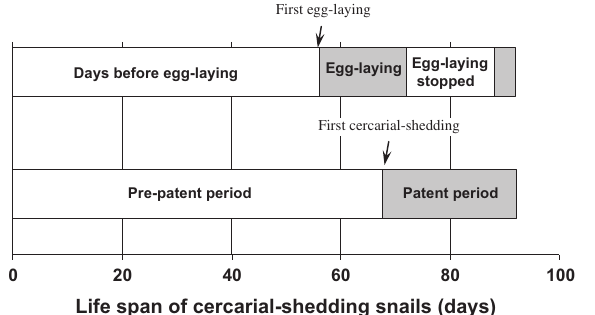
Figure 3. Mean durations of the egg-laying and patent periods for cercarial-shedding (CS) snails, with indication of dates for which egg-laying stopped and began